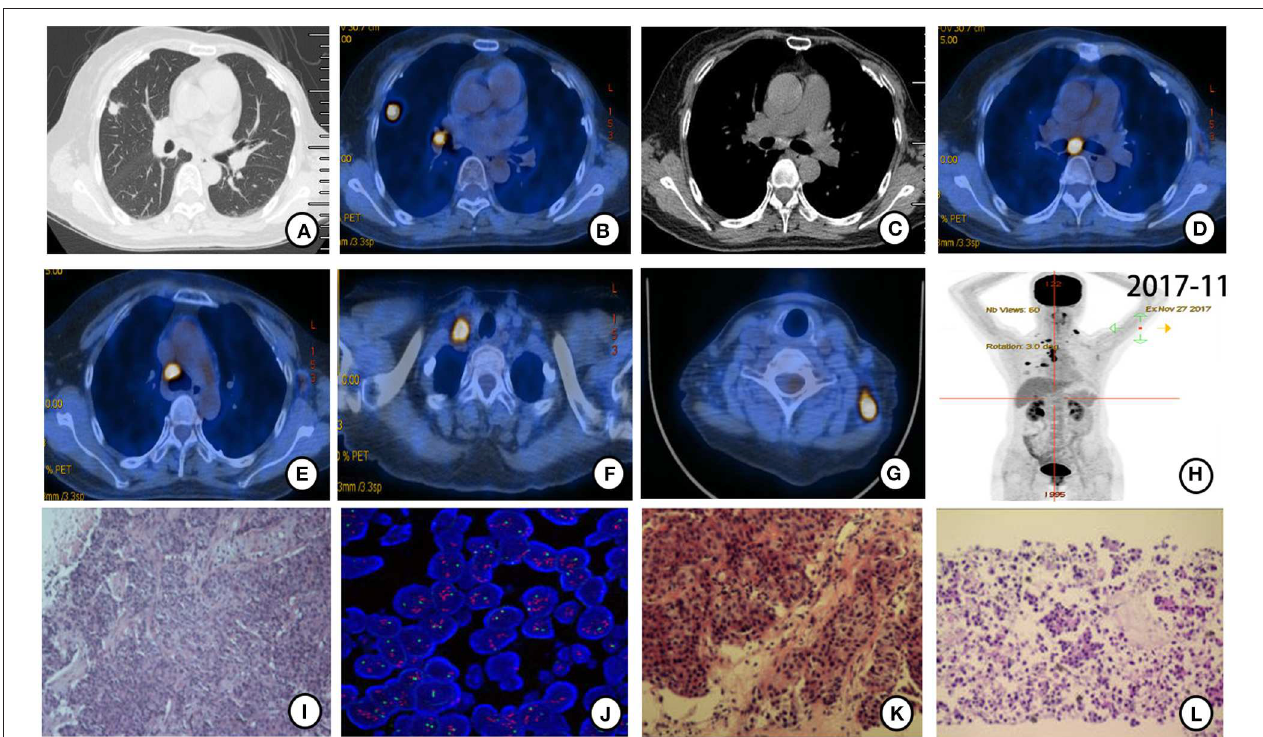
FIGURE 2 | PET-CT scan (November 2017) and histopathological and molecular results after gefitinib therapy resistance. (A,B) Original mass in the upper lobe of the right lung enlarged (1.4 × 1.1cm) with more intense FDG uptake (SUVmax = 11.24). (C,D) Right hilar and subcarinal lymph node enlarged with more intense FDG uptake. (E–G) New mediastinal, right subclavian, and bilateral cervical lymph nodes were found with FDG uptake. (H) Holistic view of PET-CT: metabolic lesions in multiple metastases. Histopathological features of ultrasound-guided biopsy tissue. (I) Cancer cells arranged in streaks and nest bulk and invasive growth manner in left cervical lymph nodes ( × 20 hematoxylin/eosin). (J) HER-2 amplification was detected by FISH in left cervical lymph nodes tissue. HER-2 signal (red) was found in clusters distributed. (K) Irregular adenoid and cord-like cancer cells were found in the biopsy tissue from the nodule in the upper lobe of the right lung ( × 20 hematoxylin/eosin). (L) Cancer cells scattered or arranged in groups observed in right hilar and subcarinal lymph nodes tissues acquired by EBUS-guided biopsy ( × 20